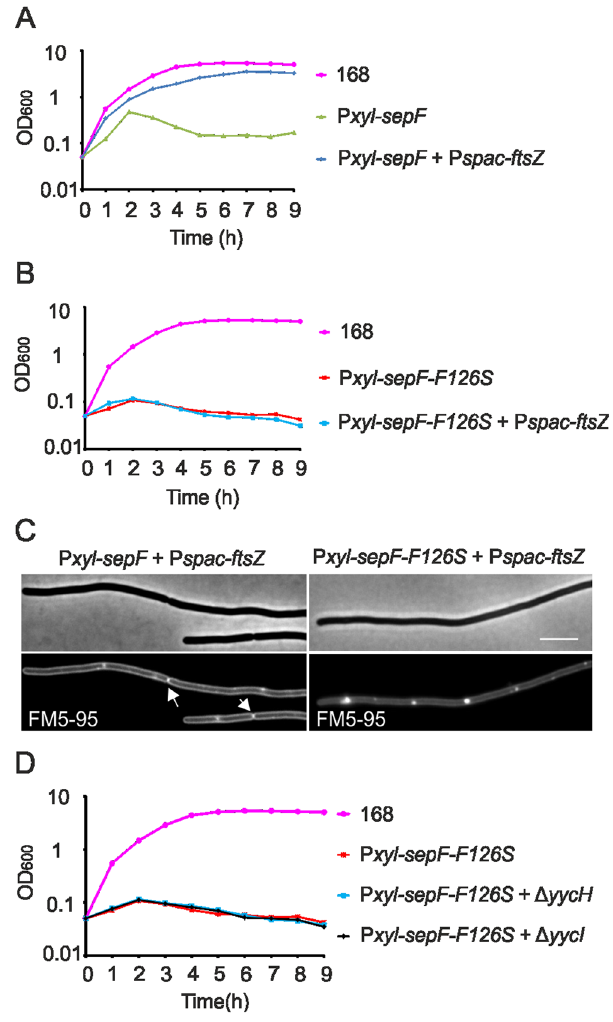
Figure 9. FtsZ induction suppresses division defect. ( A ) Growth curves of strain 168 (wild type), strain GYQ215 ( amyE ::P xyl-sepF ), and strain GYQ77 ( amyE:: P xyl-sepF aprE:: P spac-ftsZ ) in medium containing 1% xylose to induce SepF and 5 mM IPTG to induce FtsZ expression. ( B ) Growth curves of strain 168 (wild type), strain GYQ207 ( amyE ::P xyl-sepF-F126S ∆ sepF ) and strain GYQ210 ( amyE ::P xyl-sepF-F126S ∆ sepF aprE:: P spac- ftsZ ) in medium containing 1% xylose to induce SepF-F126S and 5 mM IPTG to induce FtsZ expression. ( C ) Phase contrast and membrane stain of cells from culture GYQ77 (Fig. 9A), and culture GYQ210 (Fig. 9B). Cells were stained with the membrane dye FM5-95. Scale bar is 5 µ m. Normal septa are indicated by arrows. ( D ) Growth curves of strain 168 (wild type), strain GYQ185 ( amyE ::P xyl-sepF-F126S ∆ sepF ), strain GYQ223 ( amyE ::P xyl-sepF-F126S ∆ sepF ∆ yycH ) and strain GYQ224 ( amyE ::P xyl-sepF-F126S ∆ sepF ∆ yycI ) in medium containing 1% xylose to induce SepF and